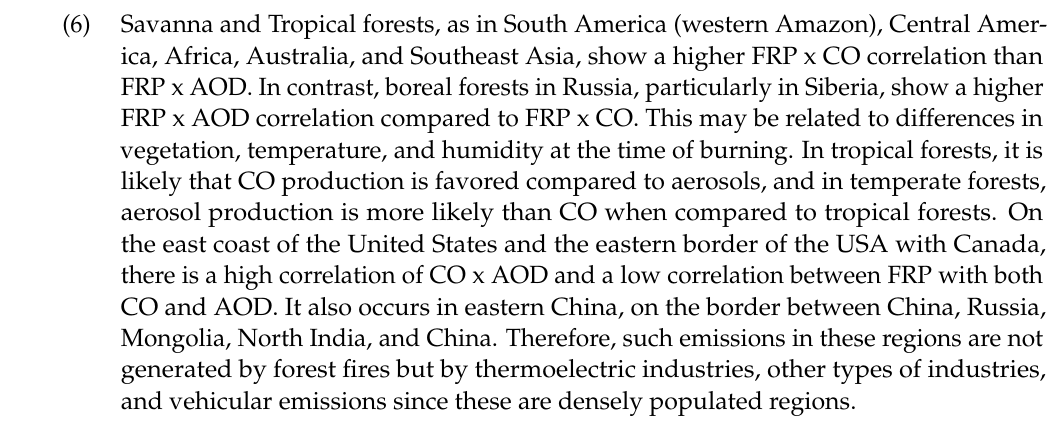
Figure S3: (a) CO (ppb) observed by MOPITT sensor for JJA, in the period of 2010-2014, (b) CO simu- lated by the CAM5-MAM3 model using tropospheric chemistry and (d) tropospheric/stratospheric chemistry mechanisms without calculating Equation (4). The right side of the figure shows the model difference minus the observation (MOPITT), (c) for tropospheric chemistry and (d) for tropo- spheric/stratospheric chemistry., Figure S4: (a) CO (ppb) observed by MOPITT sensor for SON, in the period of 2010-2014, (b) CO simulated by the CAM5-MAM3 model using tropospheric chemistry and (d) tropospheric/stratospheric chemistry mechanisms without calculating Equation (4). The right side of the figure shows the model difference minus the observation (MOPITT), (c) for tropospheric chemistry and (d) for tropospheric/stratospheric chemistry., Figure S5: (a) CO (ppb) observed by MOPITT sensor for ASO, in the period of 2010–2014, (b) CO simulated by the CAM5-MAM3 model using tropospheric chemistry and (d) tropospheric/stratospheric chemistry mechanisms without